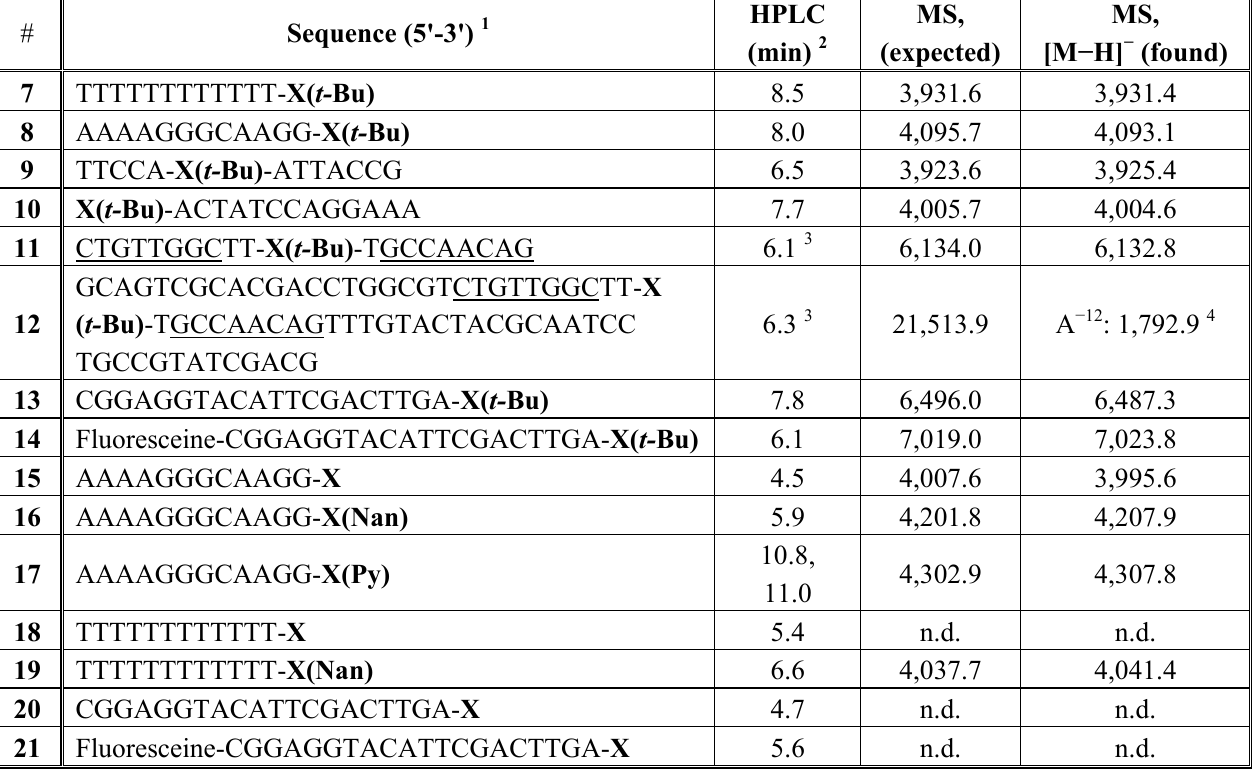
Table 1. Oligonucleotide sequences prepared in this